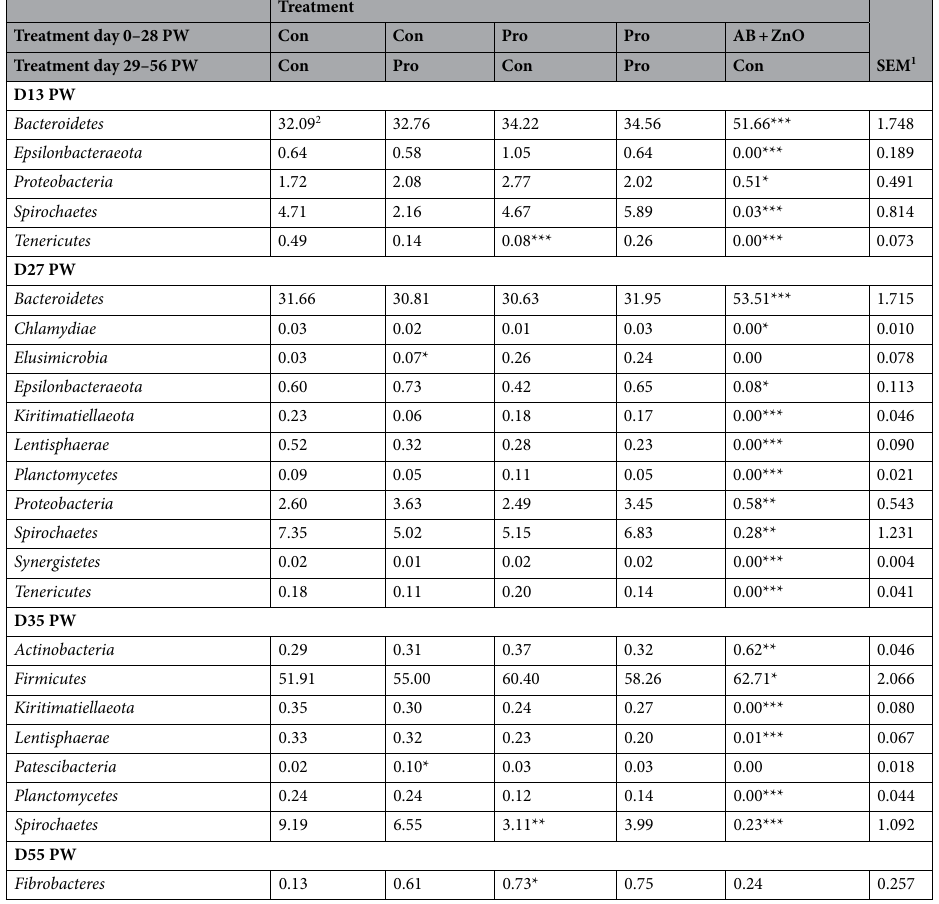
Table 4. Bacterial phyla that were differentially abundant within the faecal microbiota of pigs in the Control/ Control group and all other treatment groups. PW, post-weaning, Con, control; Pro, probiotic; AB + ZnO, antibiotic + zinc oxide. 1 Pooled standard error of the mean (SEM). 2 Relative abundances for each treatment are normalized with the total-sum scaling method. Significant differences between treatment groups and the Con/Con group are indicated as: *** ( P ≤ 0.001), ** (0.001 < P ≤ 0.01), and * (0.01 < P ≤ 0.05). No significant differences were observed at D100 PW. Statistical analysis of amplicon sequence variant (ASV) abundance was performed using DeSeq2 24 in R version 4.02 23 , where low abundance ASVs were manually filtered and a false discovery rate (FDR) of < 0.05 was indicative of significant abundance difference between groups. For each taxon, differences between the median abundances of samples in each treatment group compared to the control group (Con/Con) were assessed using the Wilcoxon Rank Sum test of the R package Metacoder 25